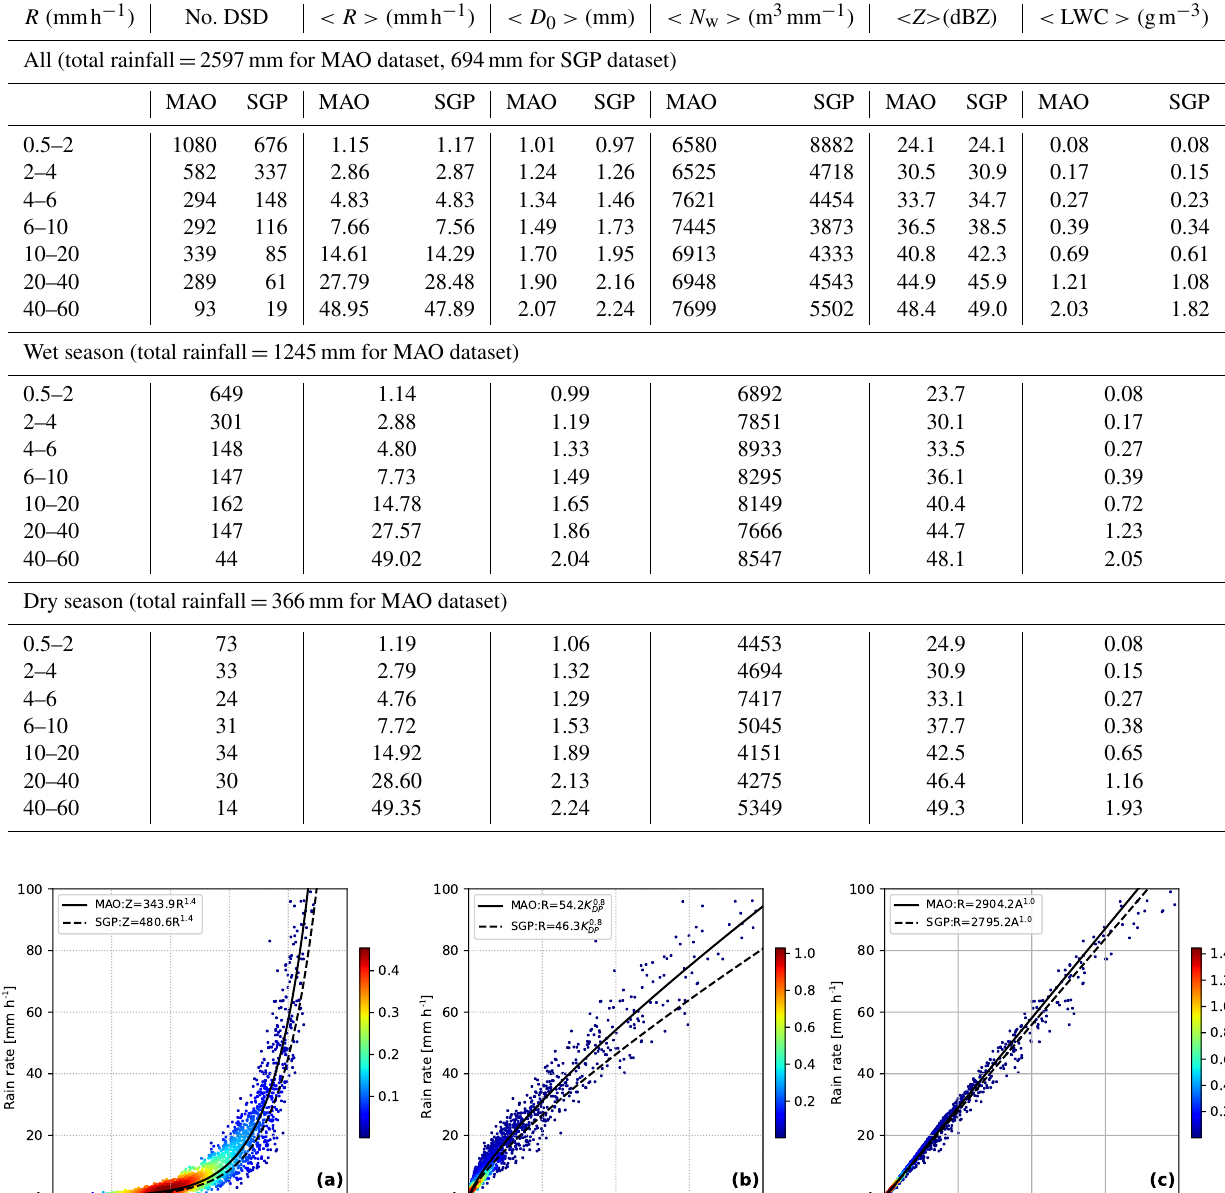
Table 1. A summary of 5min DSD parameter breakdowns for number of DSDs, rain rate R , median volume drop size D 0 , normalized DSD intercept parameter N w , reflectivity Z at S-band wavelengths, and liquid water content (LWC), filtered according to rainfall rate intervals, for all, wet and dry seasons for the Amazon (MAO) and the Southern Great Plains (SGP) sites. R (mmh − 1 ) No. DSD All (total rainfall = 2597mm for MAO dataset, 694mm for SGP dataset)